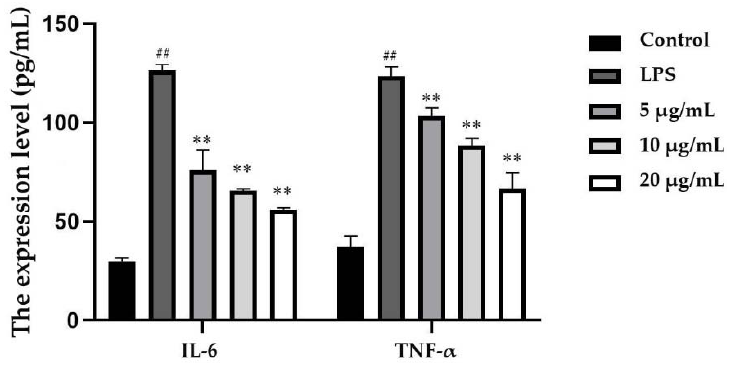
Figure 5. E ff ects of EEP-B on the levels of IL-6 and TNF- α . ## means extremely significant di ff erence Figure 5. Effects of EEP ‐ B on the levels of IL ‐ 6 and TNF ‐α . ## means extremely significant difference ( p < 0.01) between LPS ‐ stimulated group and control and ** means extremely significant difference ( p < 0.01) between propolis treatment group and LPS-stimulated group. ( p < 0.01) between propolis treatment group and LPS ‐ stimulated group.